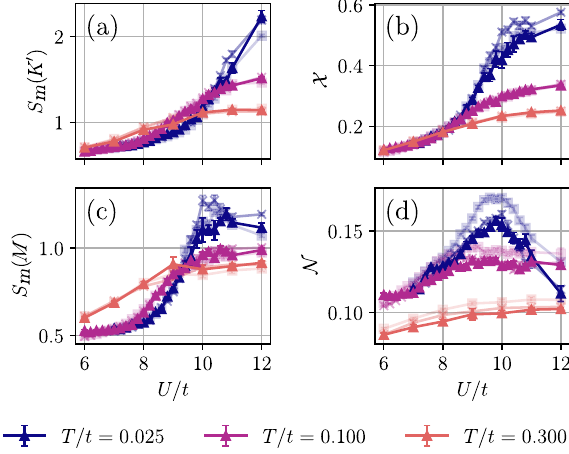
FIG. 9. The internal energy E as a function of T=t at U=t ¼ 10 on the 16 × 4 YC4 cylinder depending on the maximal bond dimension D . We compare results from simulations performed max 2000 , 3000, 4000 and find our results to agree with D max ¼ within error bars. The behavior of the energy is found to be well described by E ∝ T 2 , implying a T -linear specific heat C .